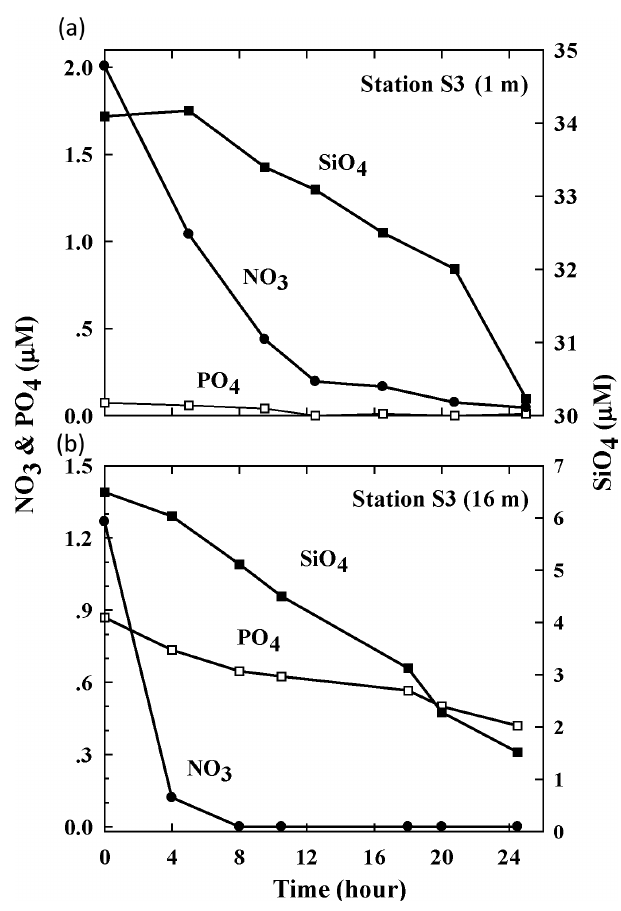
Figure 8. Time course of NO − incubation of water samples taken at Station S3 on 8 June 1989. (a) Sample taken at 1m and incubated under one layer of screen- ing; (b) sample taken at 16m and incubated under four layers of